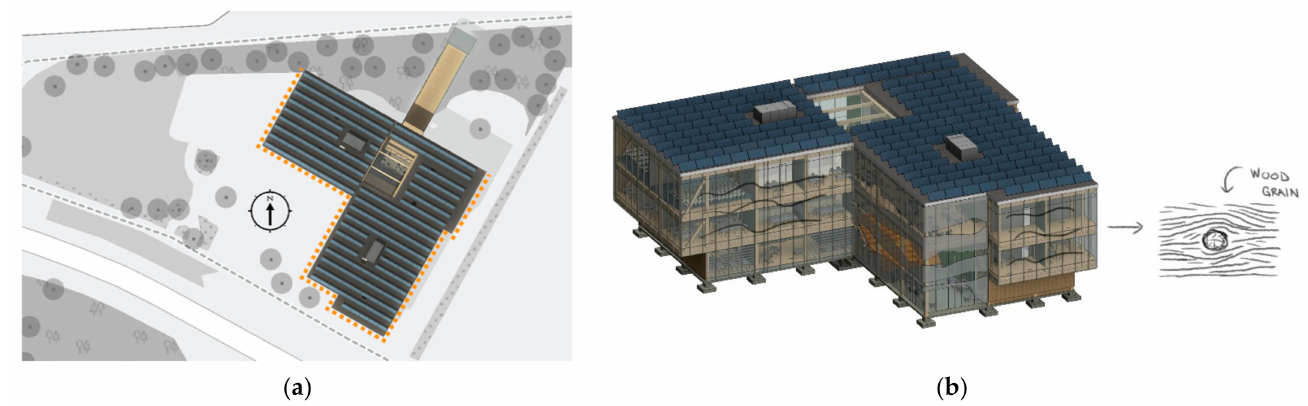
Figure 5. ( a ) Design situation. ( b ) Design problem